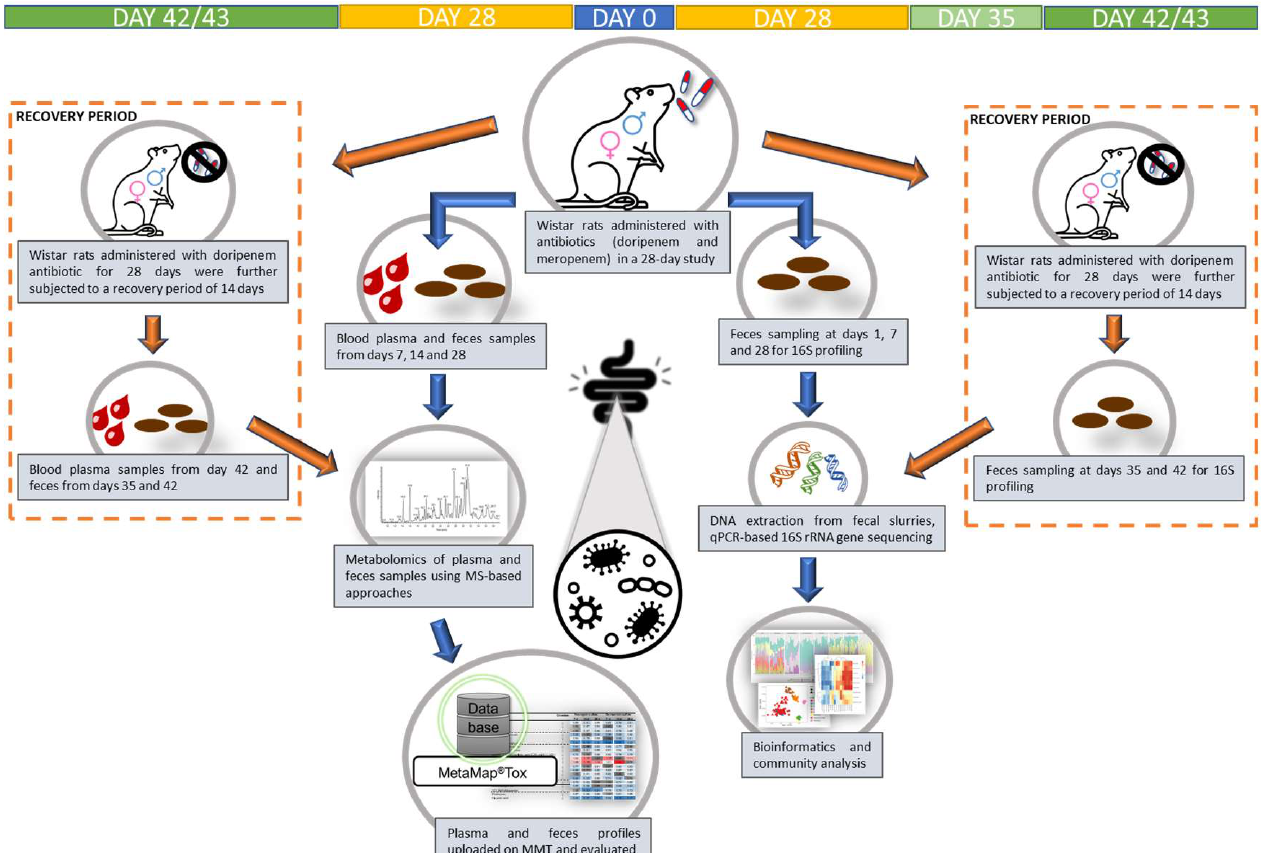
Figure 1. Schematic representation of the study design for plasma and fecal metabolome analyses and the corresponding gut (fecal) 16S bacterial profiling in a 28-day oral gavage study using meropenem- and doripenem- (administered at high and low doses) treated male and female young adult Wistar rats. Note: For doripenem, an additional one- and two-week recovery period, as indicated by the orange dashed boxes, was included to analyze the reversibility. The top row indicates sampling timeline.